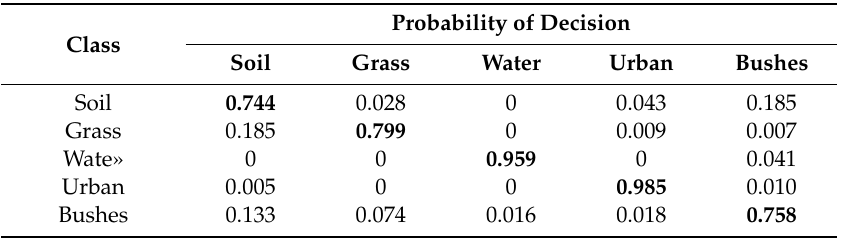
Table 16. Classification probabilities (confusion matrix) for the MLM trained for the original image and applied to the compressed image (PSNR-HVS-M = 36 dB).